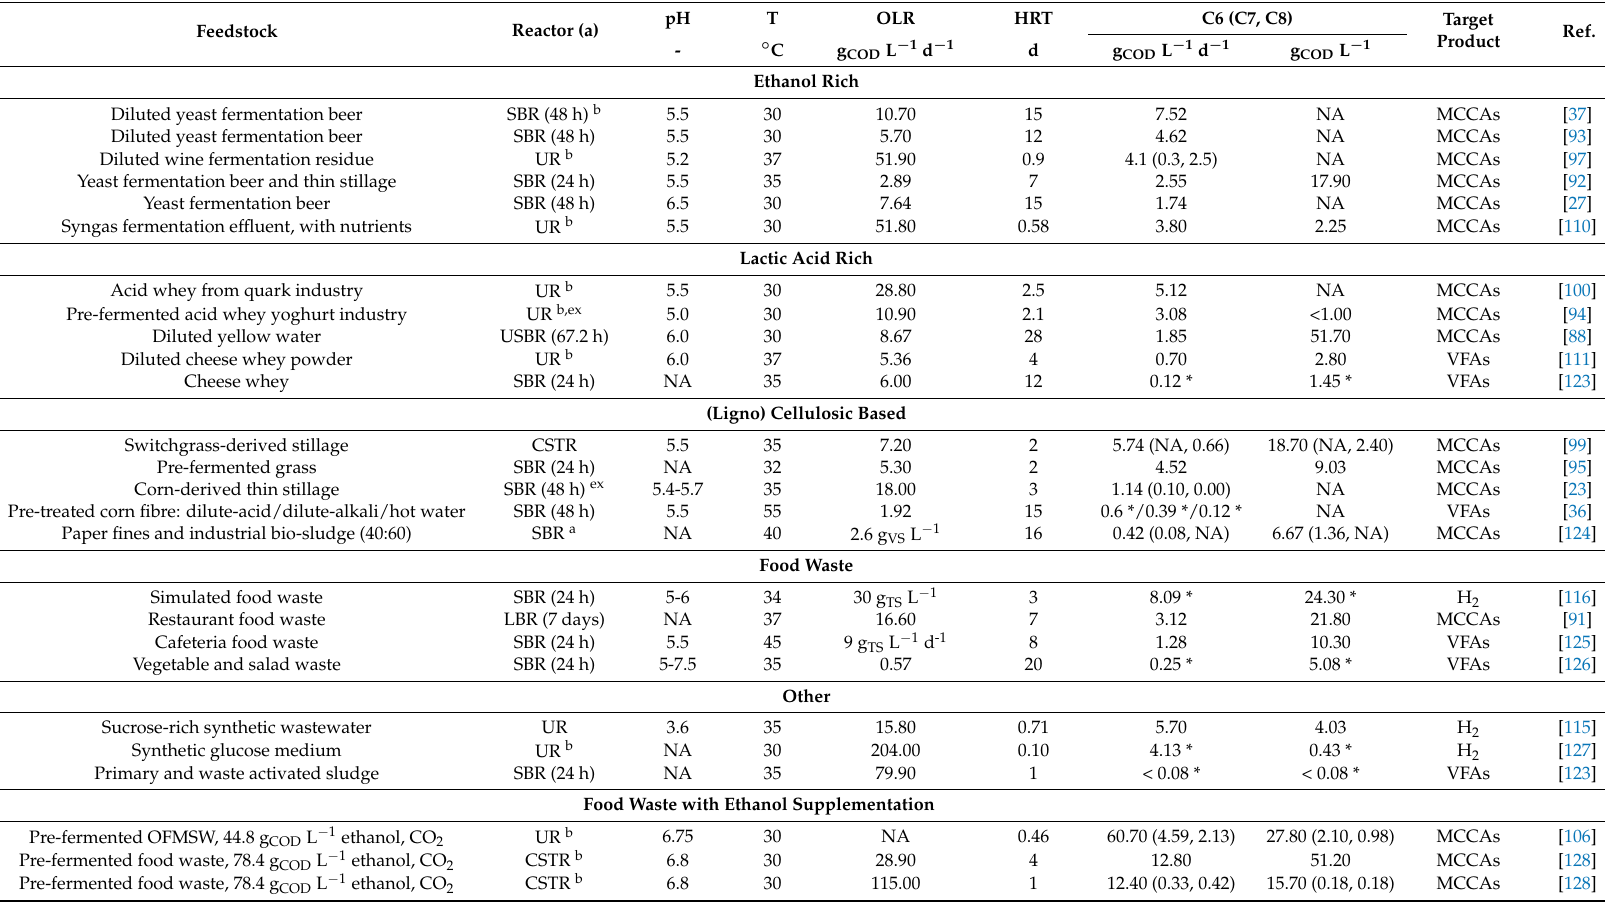
Table 3. Overview of feedstock, operating parameters and product outcome (as C6 production and C7 or C8 when data available) in continuous MMC fermentation.